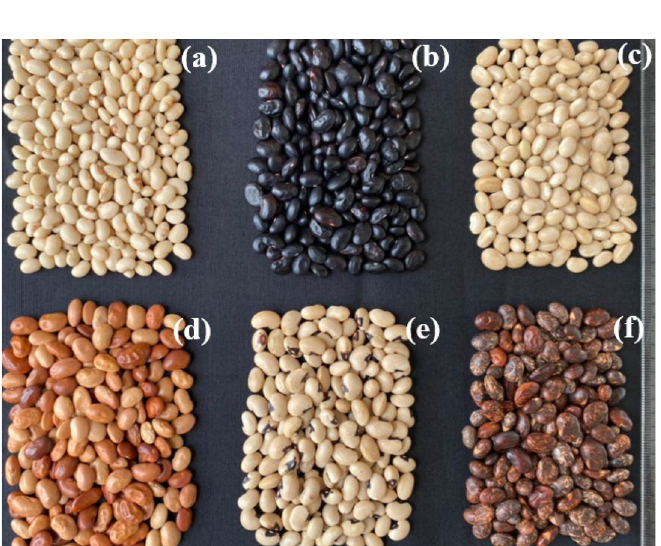
Figure 2. Kersting’s groundnut seed coat colors. ( a ) White mottled with greyed orange eye ( b ), Black, ( c ) White, ( d ) Red, ( e ) White mottled with black eye, ( f ) Brown mottled with greyed orange